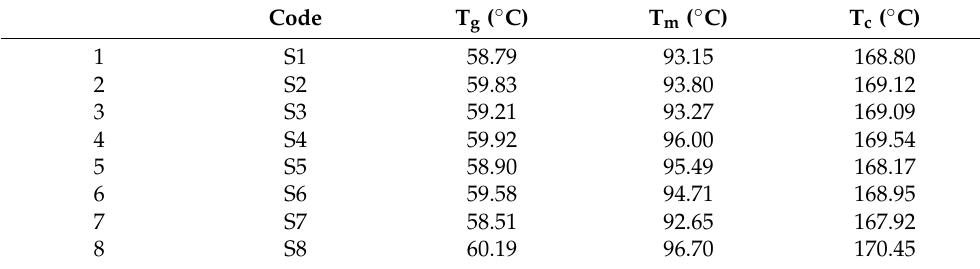
Figure 4. DSC thermogram of laminated composites . Table 4. The values of glass transition temperature (T g) , melting temperature (T m ), and the cold crystallization peak temperatures (T c ) of laminated composites .